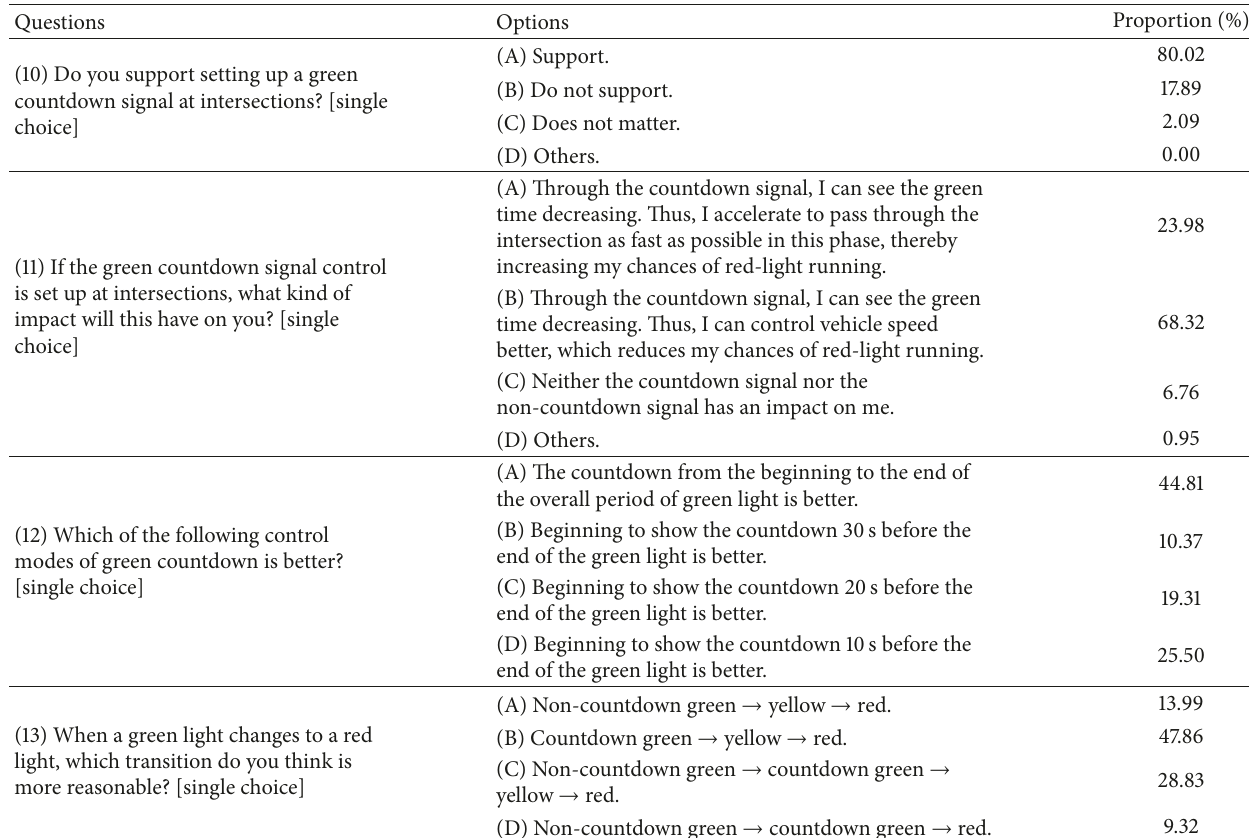
Table 3: Attitudes of surveyed drivers on green countdown signal